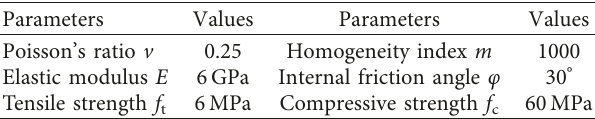
Figure 3: Geometry and boundary conditions of numerical model. Table 1: Parameters of coal-rock mass for numerical calculation.